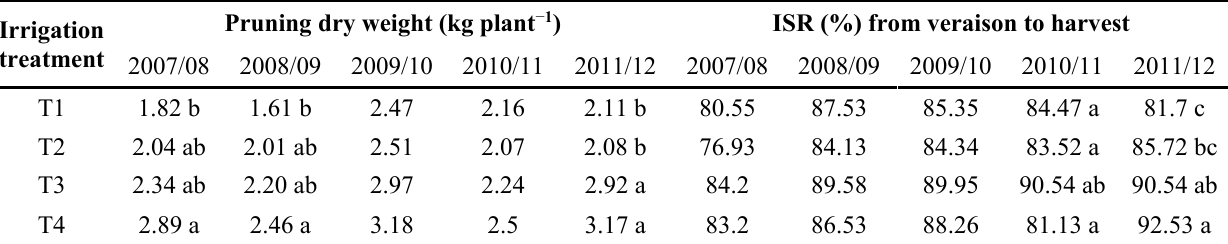
Table 4. Winter pruning dry weight (kg plant − 1 ) and average solar radiation intercepted by the vines (ISR, %) from veraison to harvest.